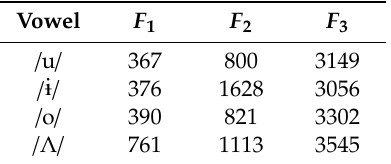
Table 2. The first three formants ( F 1 , F 2 , F 3 ) in the target Korean vowels as produced by the female model talker in participants’ Korean textbook (Seoul National University Language Education Institute 2010). All measures are in Hz for vowels produced in isolation.